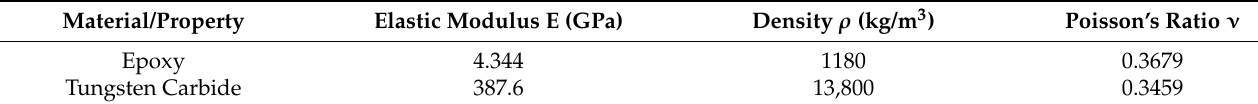
Table 1. The material properties of the matrix and inclusion used in the study.